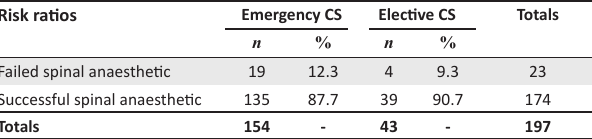
TABLE 1: Part of model answers - 2 × 2 table showing failed and successful spinal anaesthetics. Risk ratios